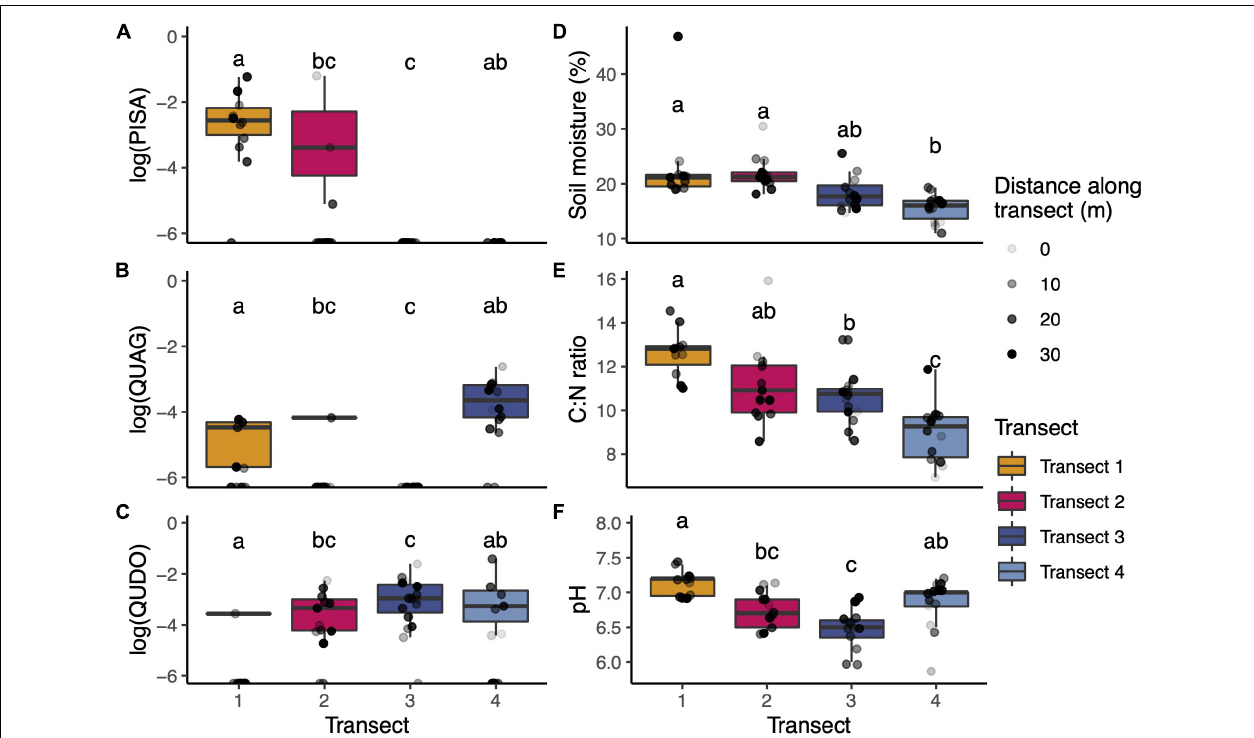
FIGURE 2 | (A–C) Aboveground plant and soil properties of transects. Transects varied in the composition of their aboveground tree communities, measured in proportion of each soil core’s field-of-view represented by each host type (note log transformation of the y -axis). (D–F) Soil chemical properties were relatively consistent across transects with the greatest variation arising in C:N ratio (correlated with PISA). Boxplots span the 25th to 75th percentile with median values marked with the horizontal line. Whiskers depict at maximum ± 1.5 times the IQR from the lower hinge. Data from individual soil cores are shown as points overlaid on each boxplot. Letters indicate statistically significant differences in transect means at the p < 0.05 level (ANOVA with Tukey’s HSD correction for multiple hypothesis